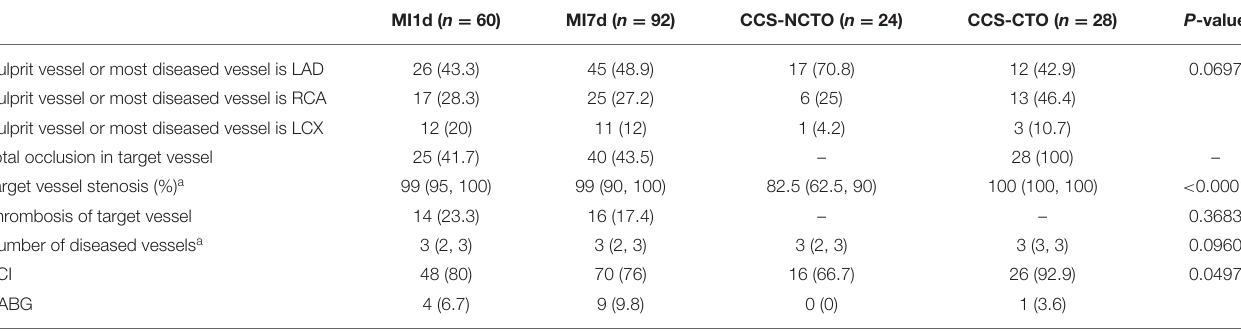
Values are displayed as mean ± SD or n (%), unless otherwise indicated. LAD, left anterior descending branch of coronary artery; RCA, right coronary artery; LCX, left circumflex branch of coronary artery; PCI, percutaneous coronary intervention; CABG, coronary artery bypass graft. a Median and interquartile